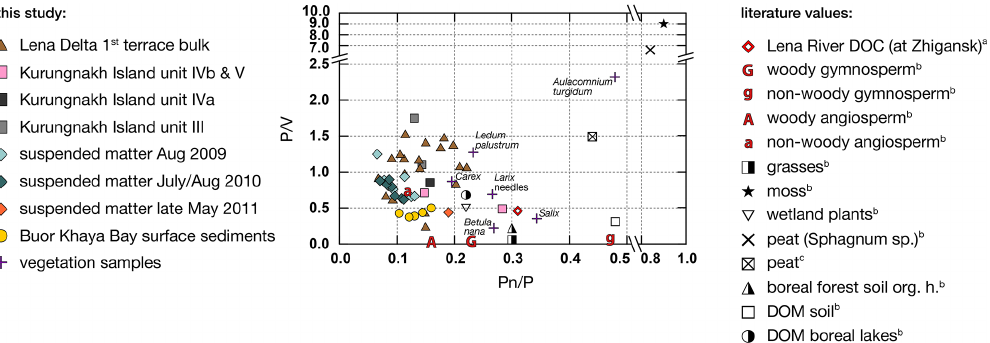
Figure 5. The ratios of p -hydroxyacetophenone to p -hydroxybenzenes (Pn / P) vs. p -hydroxybenzenes to vanillyl phenols (P / V) of samples analyzed in this study and values from the literature used as an indicator of moss contributions. a Amon et al. (2012), b Table 4 in Amon et al. (2012) and references therein, c Williams et al.